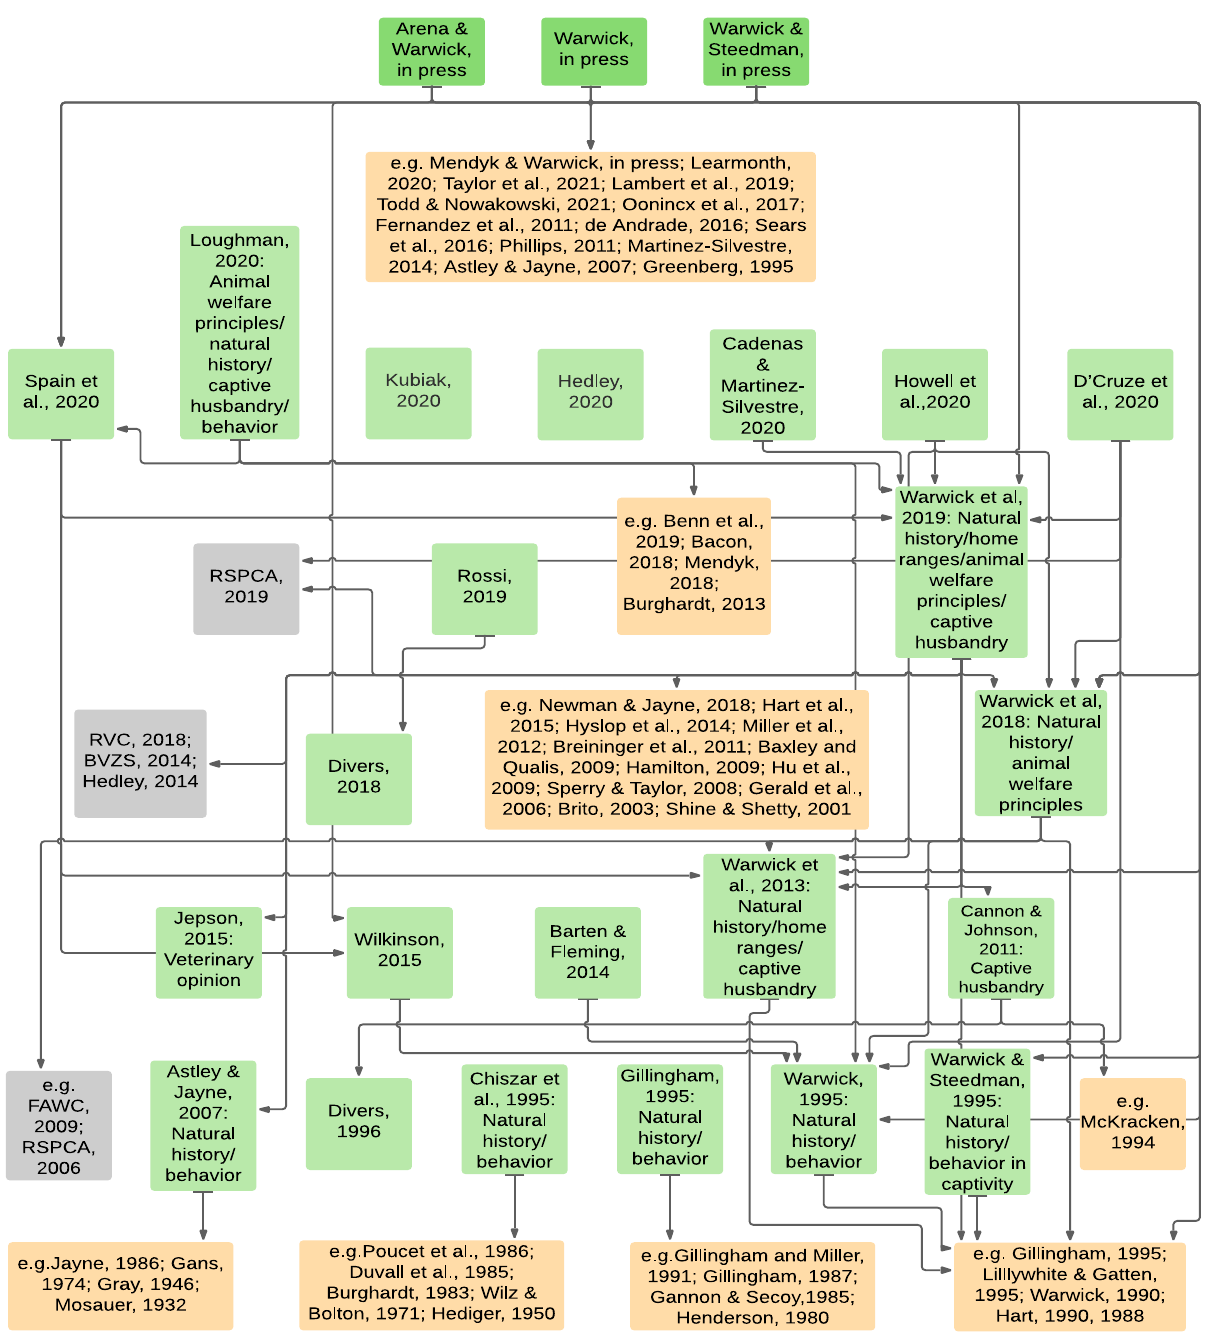
Figure 1. Peer-reviewed evidence-base showing primary cross-referencing of sources for recommended minimum snake enclosure dimensions derived from Table 3 and consistent with ≥ 1 × SL. Arrows direct to previously published material. Green boxes = peer-reviewed citations in Table 3 that specifically relate to enclosure sizes for snakes. Amber boxes = citations of general biological or behavioral nature referenced as supportive information. Grey boxes = citations of grey literature sources referenced as supportive information. Grey boxes indicate non-peer-reviewed (grey literature) publications